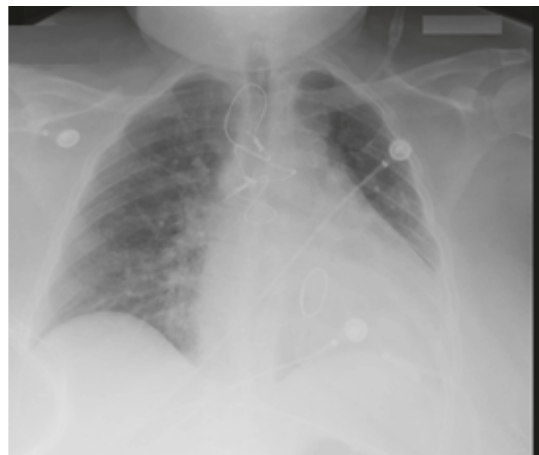
Figure 4: Near-total resolution of left-sided pleural effusion. Left- sided Pigtail (12-Fr) catheter and sternal wires are noted as